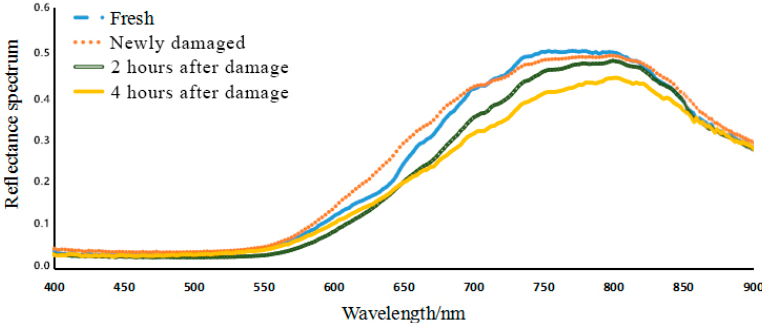
Figure 5. Hyper-spectral reflectance curves of different quality litchis.